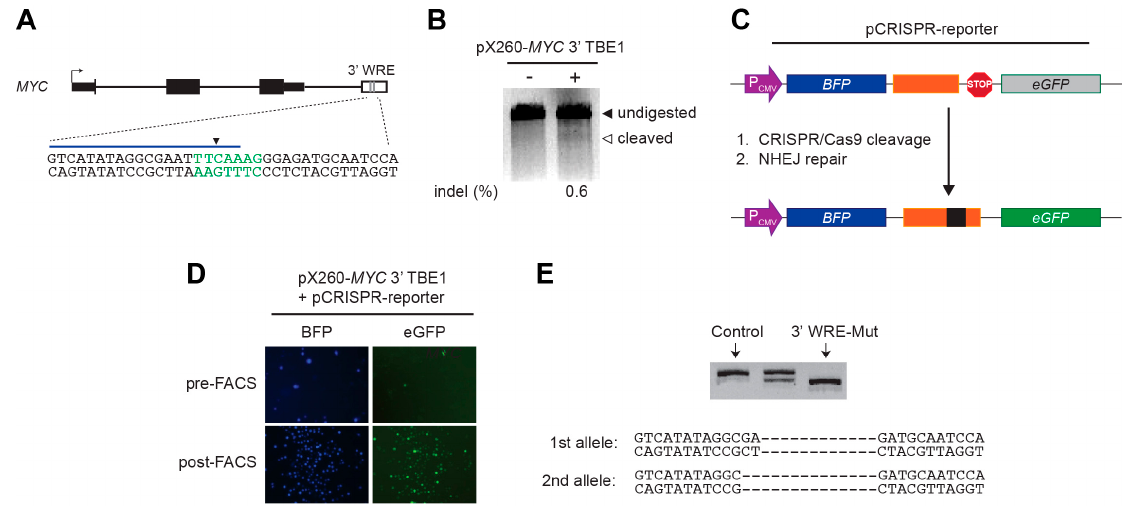
Figure 1. Generation of the 3 ′ WRE ‐ Mut cell line. ( A ) Diagram of the MYC gene with the 3 ′ WRE depicted by an open rectangle and two vertical grey lines corresponding to the TBE motifs. A strong potential CRISPR/Cas9 cleavage site that overlapped with TBE1 was identified using the CRISPR Design tool [15]. In the expanded view, the TBE1 motif is in green text, the region targeted by the CRISPR guide RNA is depicted by a blue line and the predicted cleavage site indicated by an inverted triangle; ( B ) synergel/agarose gel showing cleavage products obtained from SURVEYOR assays conducted on HEK293T cells transfected with the pX260 ‐ MYC 3 ′ TBE1 plasmid; ( C ) diagram of the pCRISPR ‐ reporter plasmid with the MYC 3 ′ WRE target region depicted by an orange rectangle. When the reporter is cleaved by MYC 3 ′ WRE ‐ specific CRISPR/Cas9, repair of the plasmid by NHEJ results in eGFP expression; ( D ) images of HCT116 cells transfected with pCRISPR ‐ reporter and pX260 ‐ MYC 3 ′ TBE1 before and after FACS sorting; ( E ) polyacrylamide gel of PCR products generated from HCT116 single ‐ cell clones subjected to CRISPR/Cas9 gene editing. Below, sequence of the targeted alleles in 3 ′ WRE ‐ Mut cells displaying deletions in TBE1.